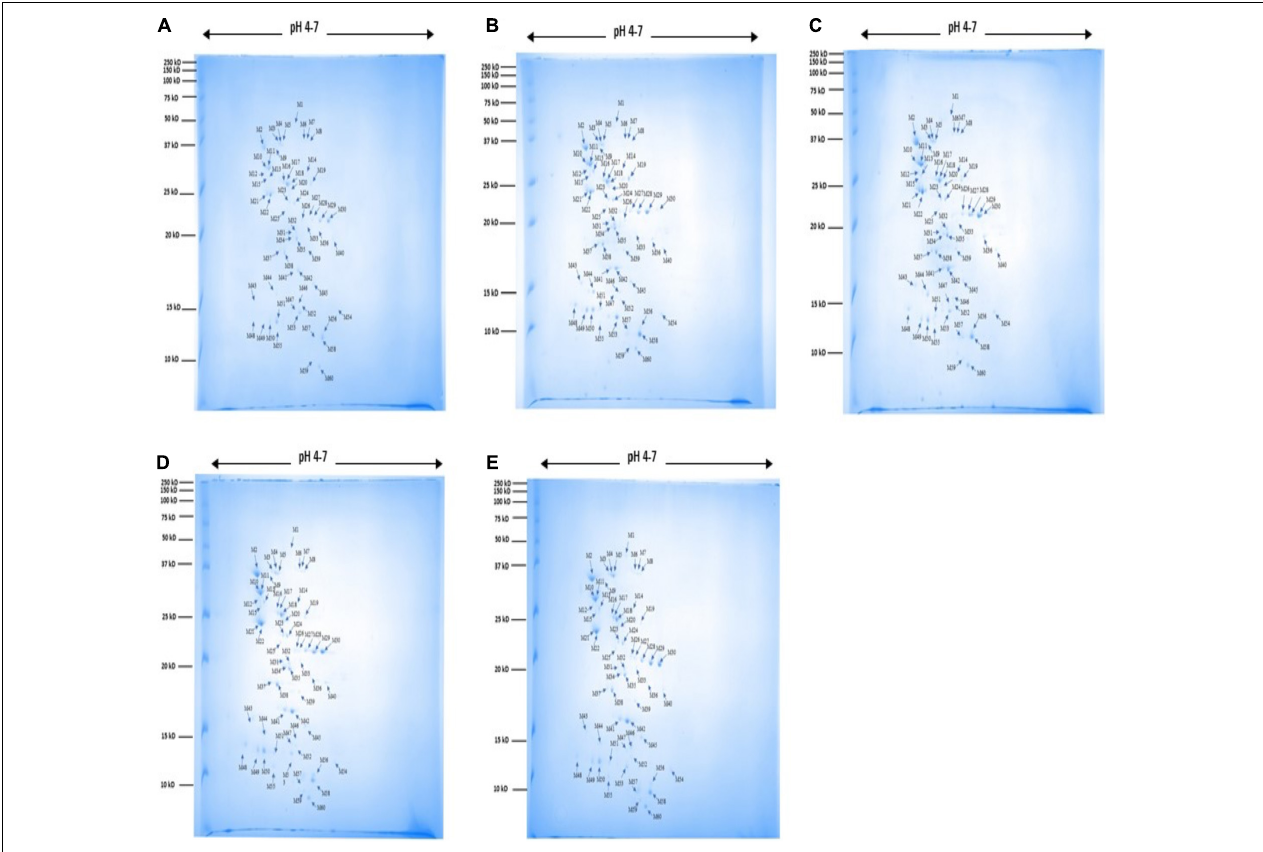
FIGURE 2 | 2DE gel images for protein expression profile of P. pentosaceus M41 under heat, cold, acid and bile stresses. (A) Control, (B) heat, (C) cold, (D) acid, (E) bile. The arrow indicates proteins which were quantitatively analyzed by MelanieTM Version 9.2.3 (Swiss Institute of Bioinformatics, Lausanne, Switzerland). The protein spots were identified by PhaseNano-LC-MS/MS analysis and assigned identities/functions are listed in Table 1